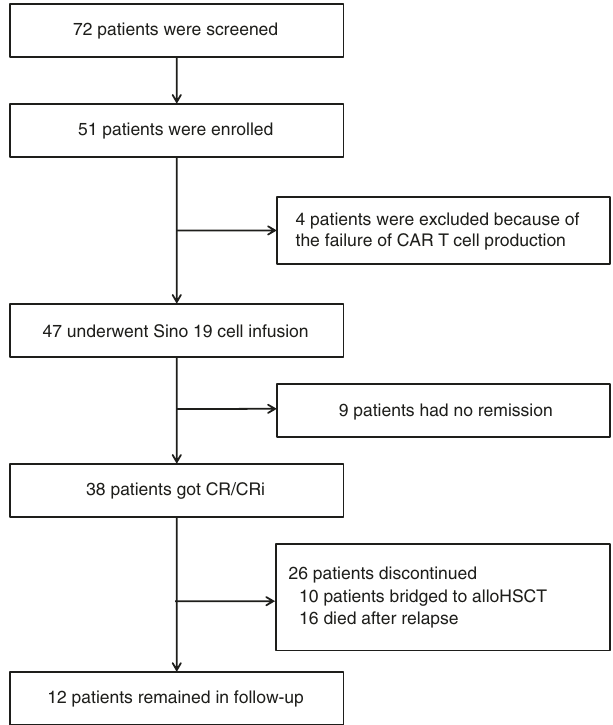
Fig. 1 Consort diagram. A total of 72 patients with r/r B-ALL were screened, 51 who met the inclusion criteria and did not meet the exclusion criteria were enrolled; 4 patients did not have Sino 19 cell infusion due to production failure. Ultimately, 47 patients received Sino 19 cell infusion; 9 of them had no remission. 38 patients achieved CR/CRi; 10 of them were bridged to allo-HSCT; 19 out of the remaining 28 patients who were not bridged to allo-HSCT relapsed, out of which 16 died. Twelve patients remained in follow-up at the time of data cut off, which included 3 relapsed patients and 9 with sustained remission. Source data is provided as a Source Data fi le or available at https://doi.org/10.6084/m9. fi